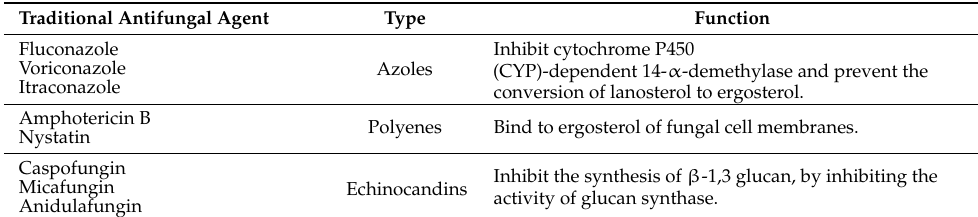
Table 1. The effects of traditional antifungal agents on C. albicans